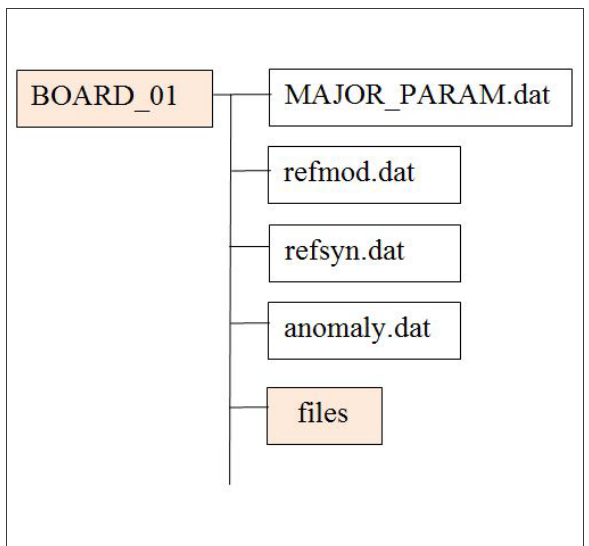
Figure A.4. Description of the synthetic modelling